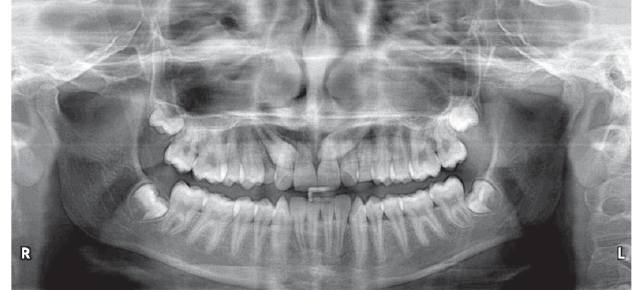
Fig. 4: Panoramic radiograph with bilateral impacted canines.